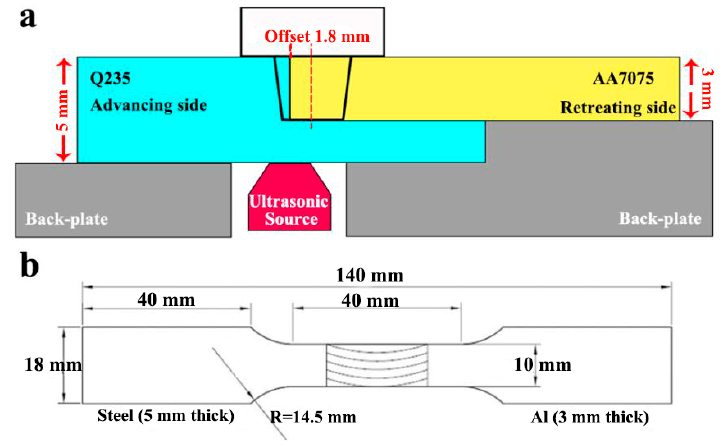
Figure 1. The schematics of ( a ) UaFSW and ( b ) tensile specimen used in the present work. The FM-700 Vickers hardness tester (HV; FUTURE-Tech, Tokyo, Japan) was em- ployed to measure the distribution of hardness through the whole joint; the tested line was along the mid-thick of upper AA7075 plate, which started from Q235 at the advancing side and ended in AA7075 at the retreating side. Each tested line contained 30–40 meas- ured points and the distance between the adjacent measured points was 0.5 mm. The test load and dwelling time are 50 gf and 5 s, respectively. Moreover, the mechanical perfor- mance of joint was evaluated by the tensile test (TS; Instron-5969, Beijing, China). The tensile specimens were produced perpendicular to the welding direction with a gauge of 40 mm length and 10 mm width (as shown in Figure 1b). The crosshead speed during tensile test was kept as 1.5 mm/min, and the peak tensile load of each joint was tested three times for average. The specification for the tensile specimen used is ISO 6892:1998.